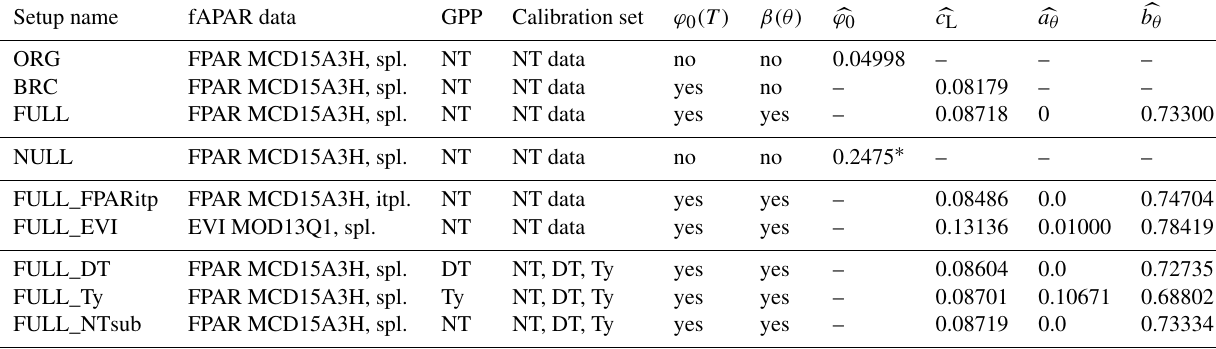
Table 1. Model setups. The standard fAPAR data are MODIS FPAR MCD15A3H, where the original data, given at 4d intervals, are splined to daily values (“spl.”). Alternative greenness forcing data are based on MODIS EVI MOD13Q1, splined from 8d intervals to daily, and MODIS FPAR MCD15A3H, linearly interpolated (“itpl.”) from 4d intervals to daily. Standard observational GPP data, used for model calibration and evaluation, are from FLUXNET 2015, based on the nighttime flux decomposition method (“NT” in the table, variable GPP_NT_VUT_REF in FLUXNET 2015). Alternative GPP data used based on the daytime flux decomposition method (“DT” in the table, variable GPP_DT_VUT_REF ) and based on an alternative method (Wang et al., 2017a) (“Ty” in the table). For the ORG, BRC, FULL, FULL_FPARitp, and FULL_EVI setups, data used for the model calibration are from all dates where NT data are available. For FULL_DT, FULL_ Ty, and FULL_NTsub setups, calibration data are from all dates where data are available for all three methods (DT, NT, and Ty). Column ϕ 0 (T ) specifies whether the temperature dependence of intrinsic quantum yield is included. Column β(θ) specifies whether soil moisture stress is included. Columns (cid:98) ϕ 0 , (cid:98) c L , (cid:98) a θ , and (cid:98) b θ provide the calibrated parameter values in each simulation